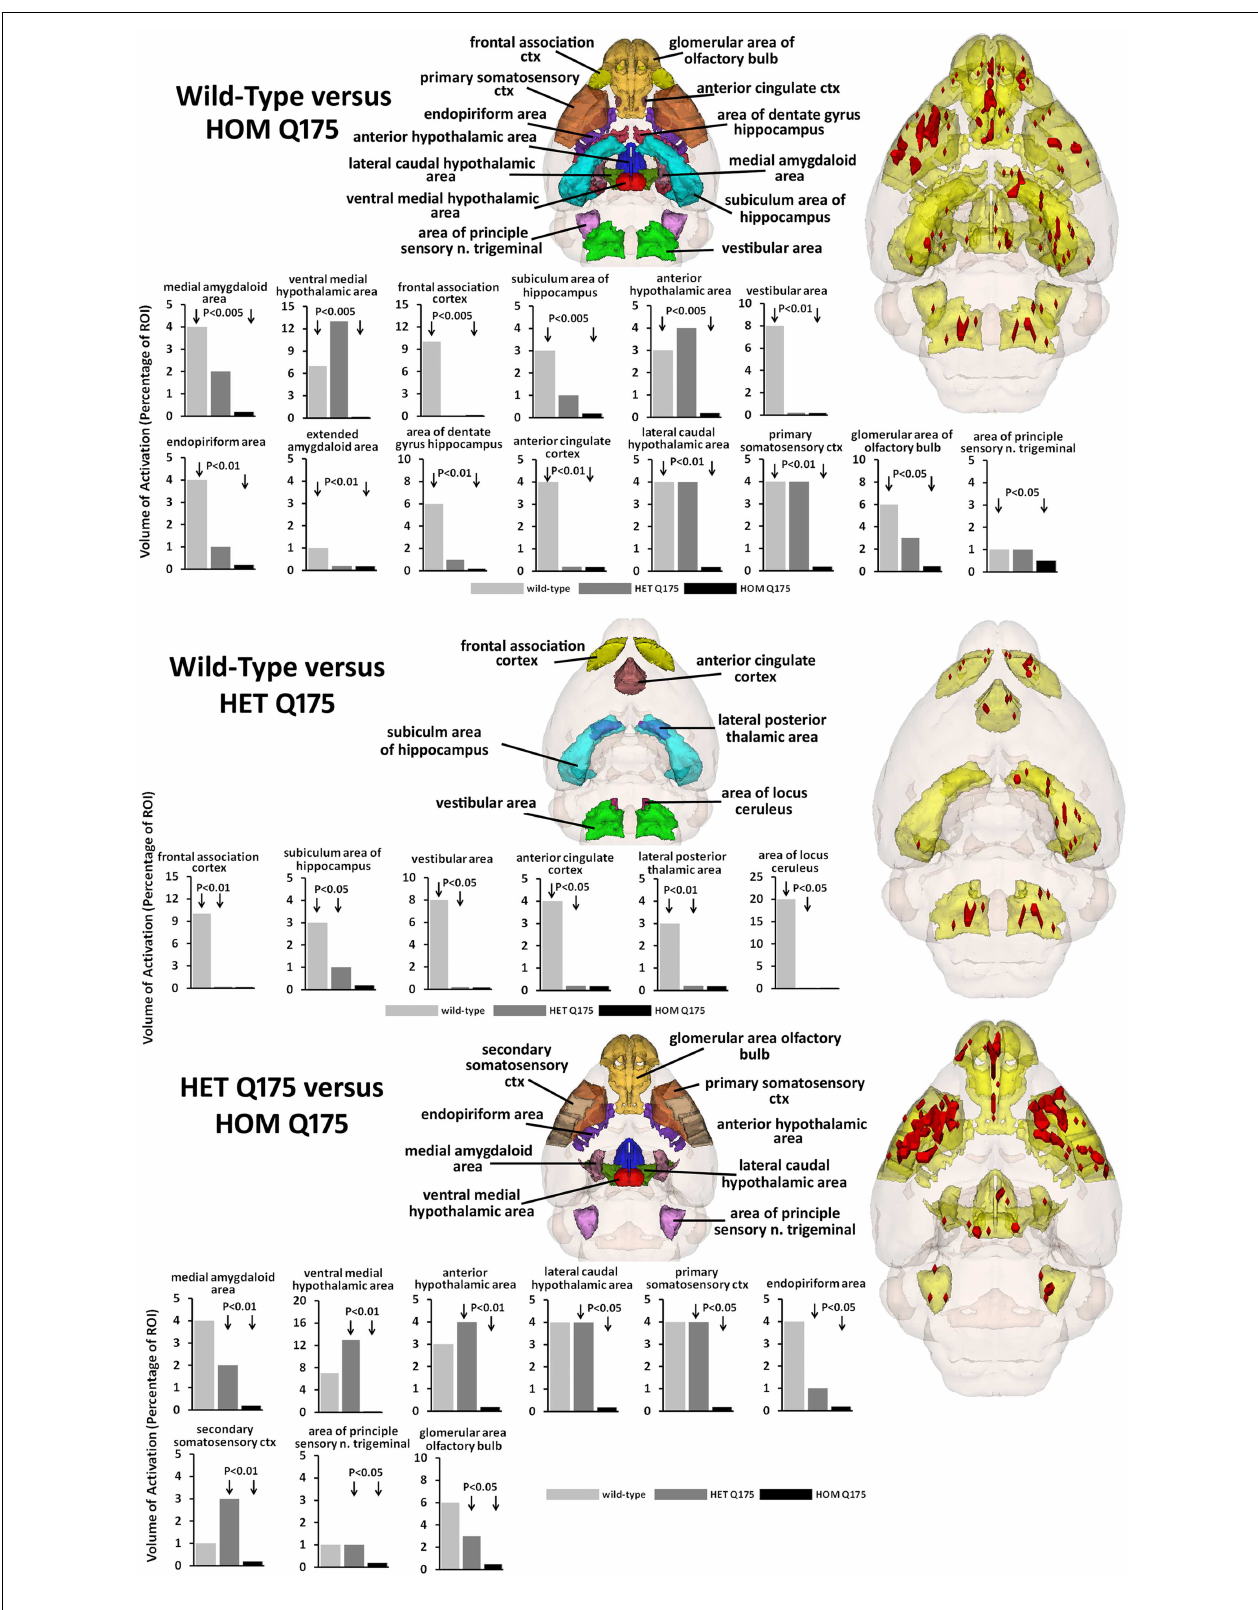
FIGURE 4 | Gene-dose effect in response to almond odor